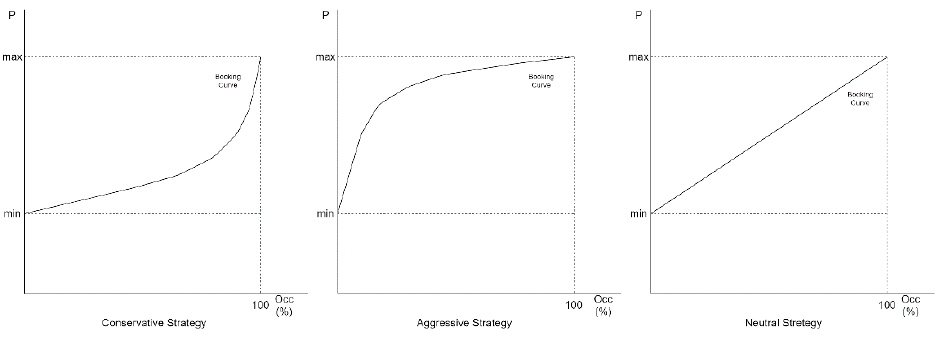
Figure 3. Booking curves.